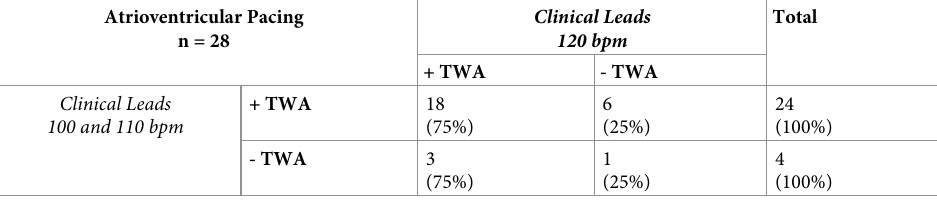
Table 5. Effect of pacing rate on clinically +TWA during atrioventricular pacing. Atrioventricular Pacing n =